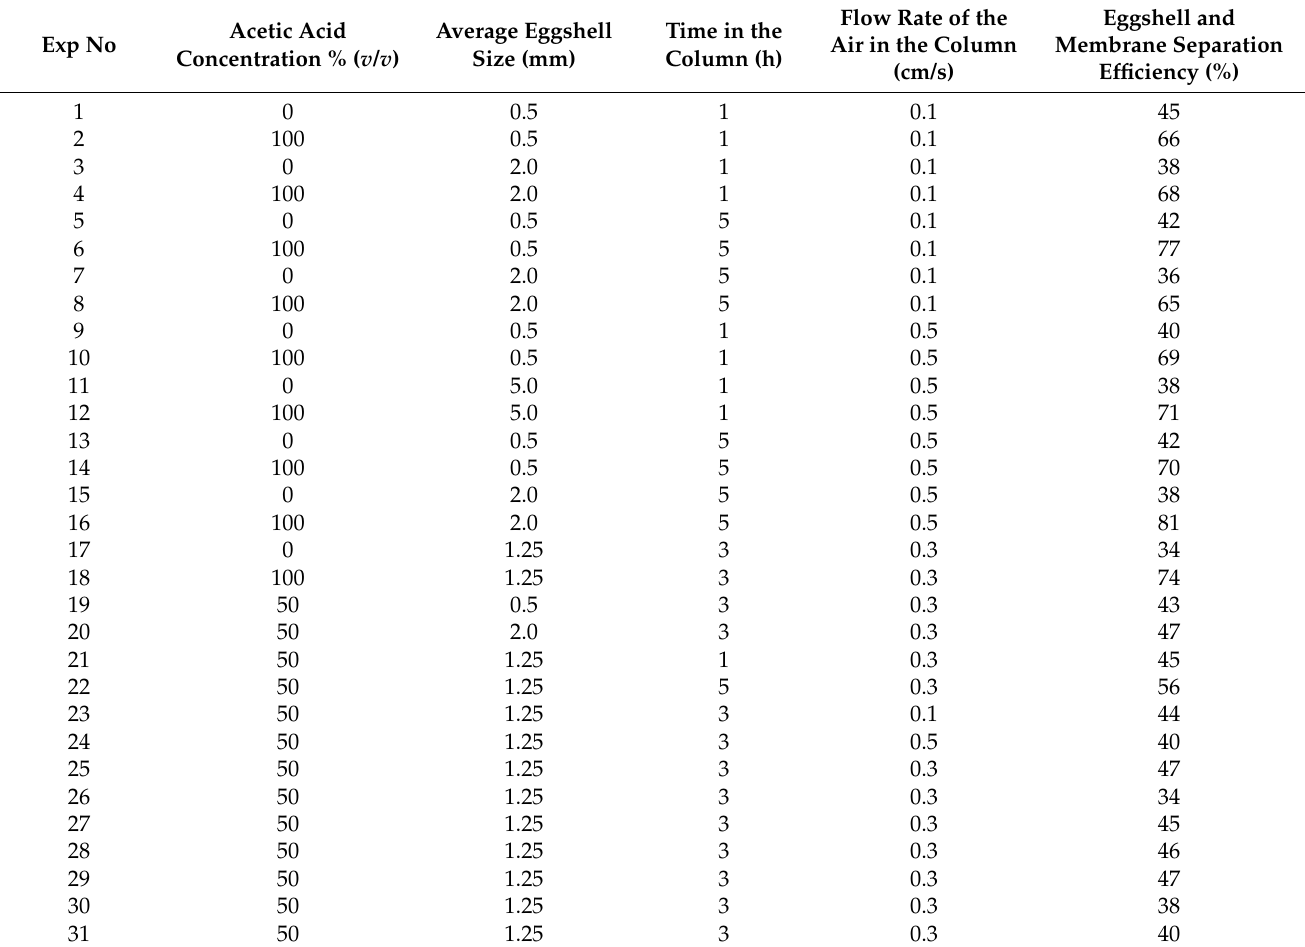
Figure 5. HPLC Chromatogram of addition of OLE in ESM at 2 different concentrations: ( a ) 3% ( w/v ) and ( b ) 2% ( w/v ). (1) hydroxytyrosol, (2) tyrosol, (3) catechin, (4) caffeic acid, (5) vanillic acid, (6) vanillin, (7) rutin, (8) luteolin-7-glucoside, (9) verbascoside, (10) apigenin-7-glucoside, (11) diosmetin-7-glucoside, (12) oleuropein, and (13) luteolin Table 2. Central Composite Design (CCD) matrix and experimentally observed